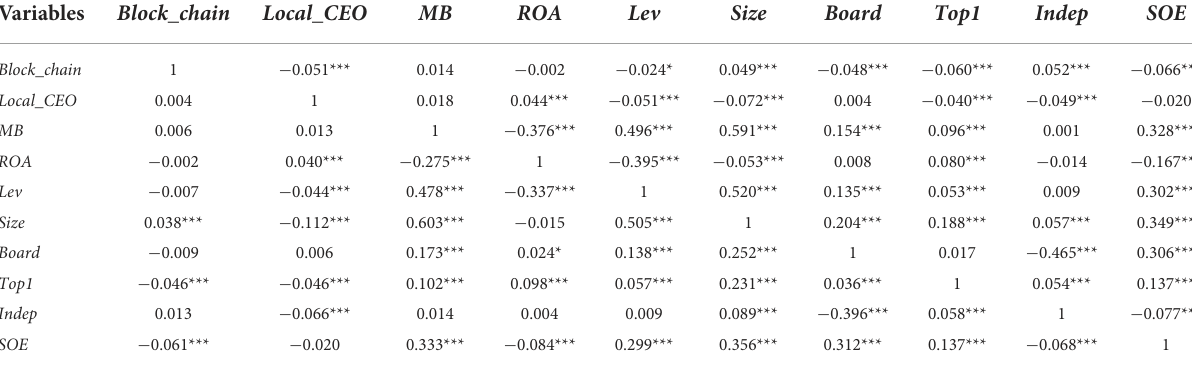
TABLE 2 Correlation coefficient matrix.